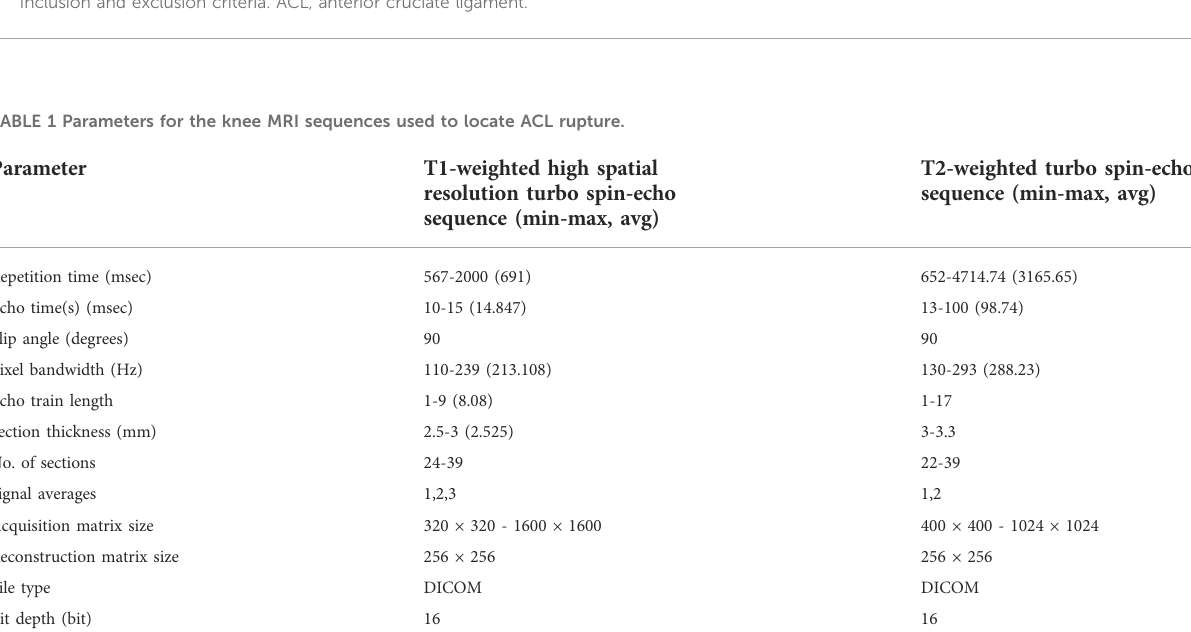
FIGURE 1 Inclusion and exclusion criteria. ACL, anterior cruciate ligament.